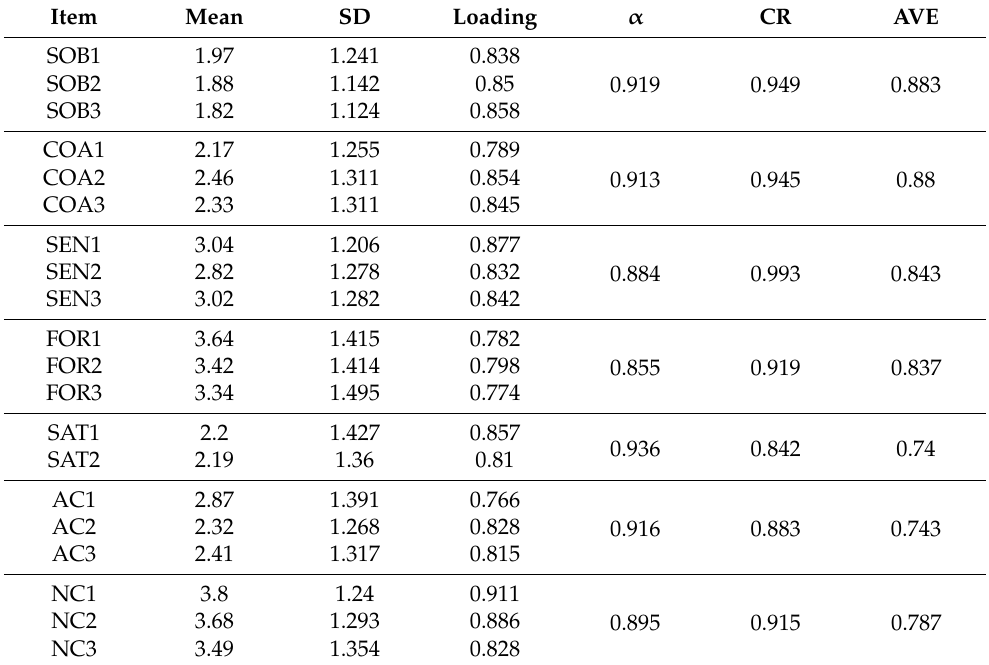
Table 3. Reliability and validity of